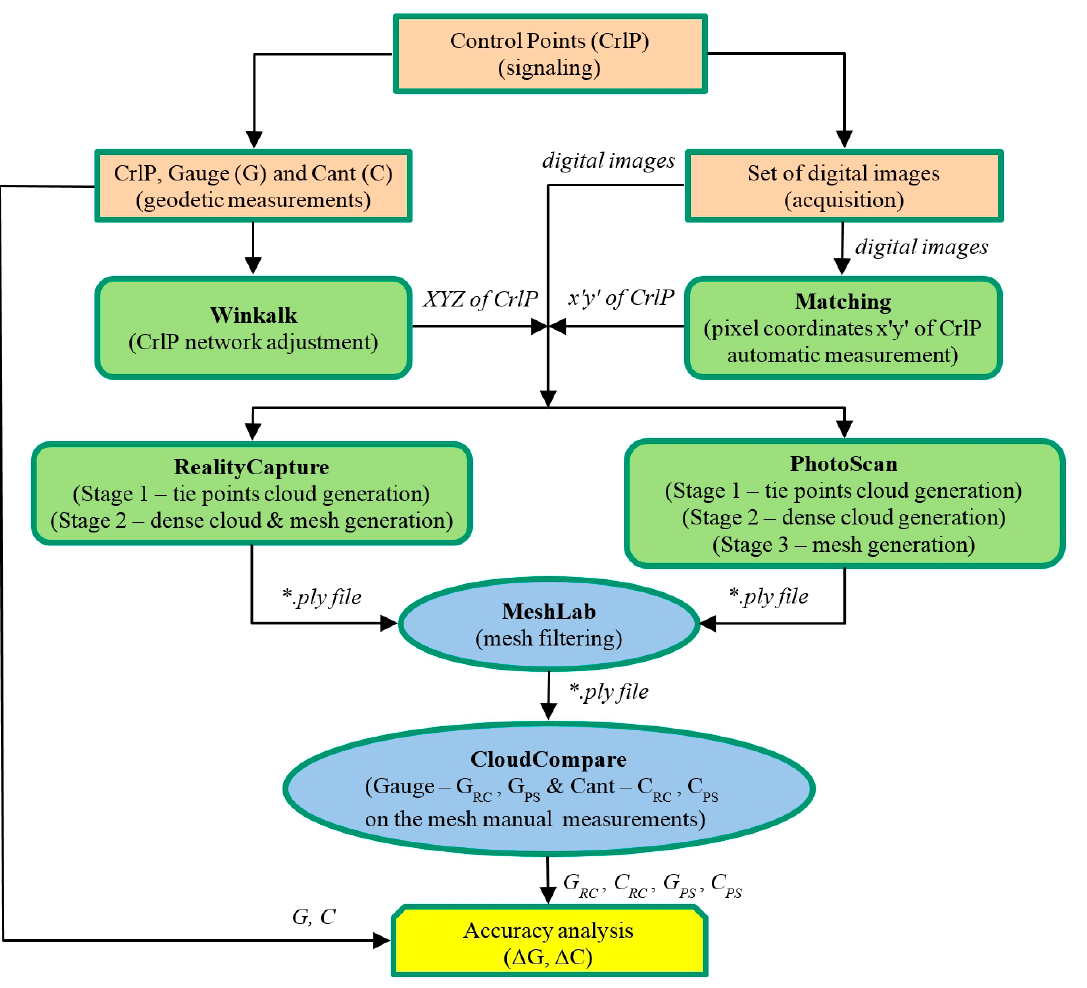
Figure 3. Measurement and processing workflow in the tests.